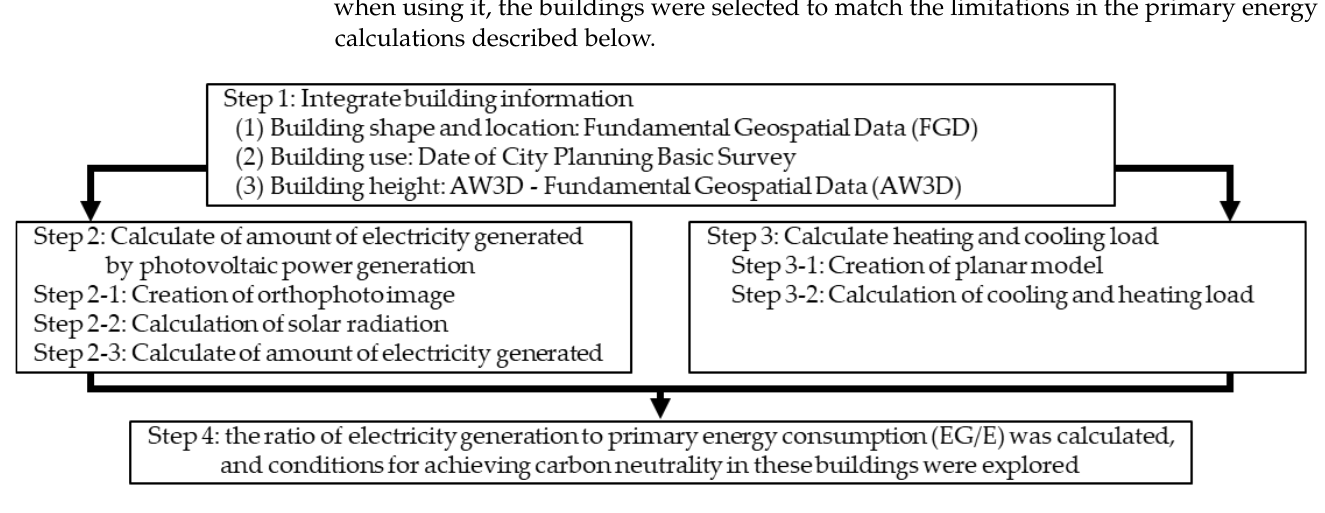
Figure 1. Study procedure flow.